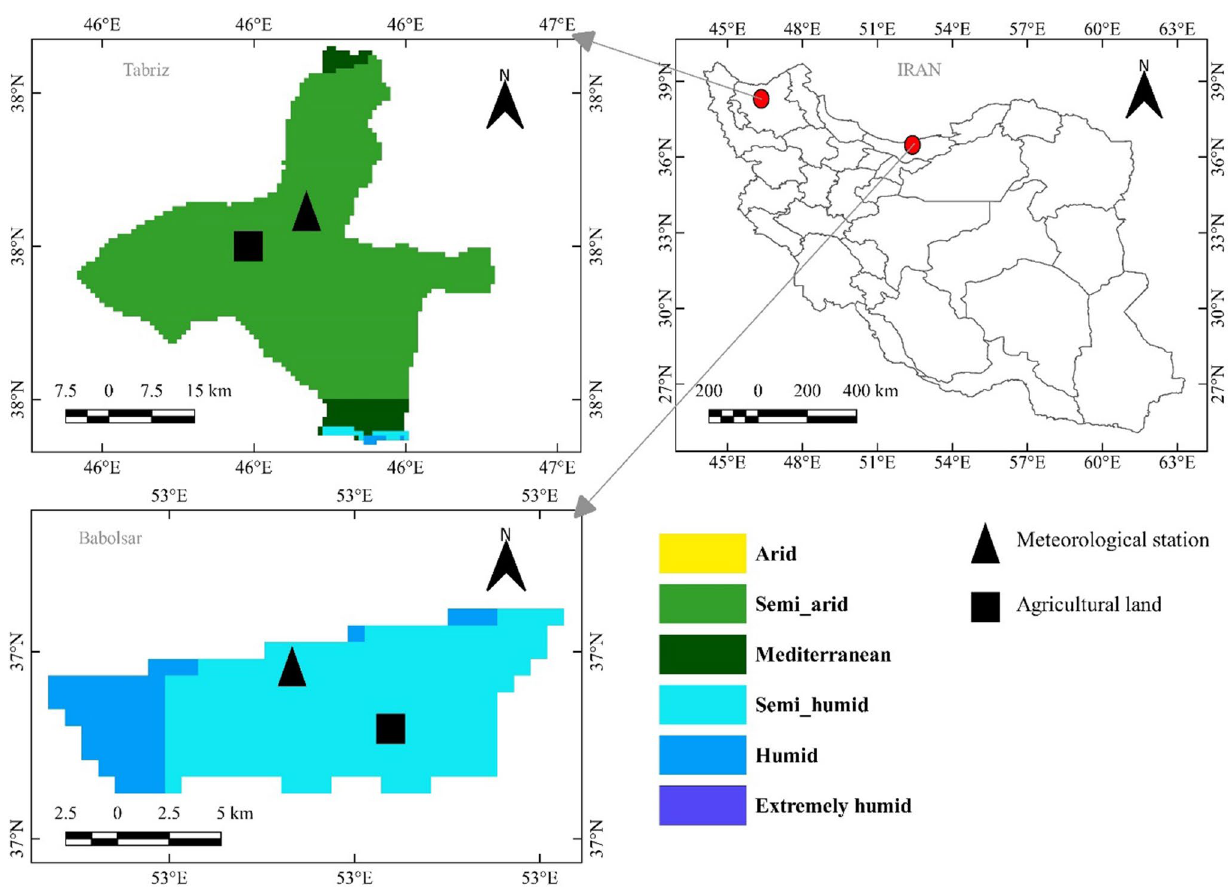
Fig. 1 Location of the study